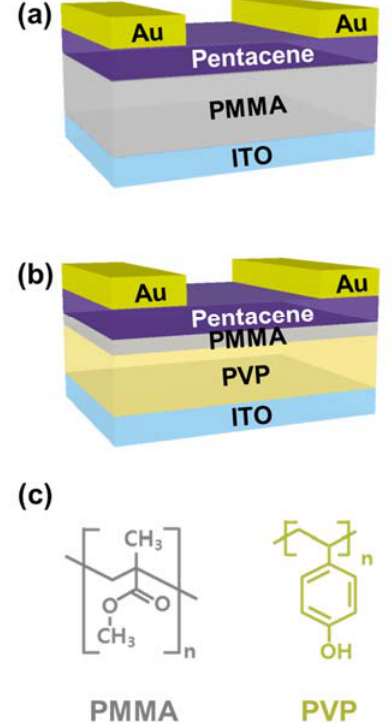
Figure 1. Schematic diagrams of structures of organic phototransistors (OPTs) with ( a ) a single-polymer poly(methyl methacrylate) (PMMA) gate insulator, and ( b ) a hybrid poly(4-vinylphenol) (PVP) / PMMA gate insulator. In the device with the hybrid gate insulator, PVP is a photoresponsive layer, and PMMA is an interfacial layer. ( c ) Chemical structures of PMMA (left) and PVP (right). ITO = indium tin oxide.